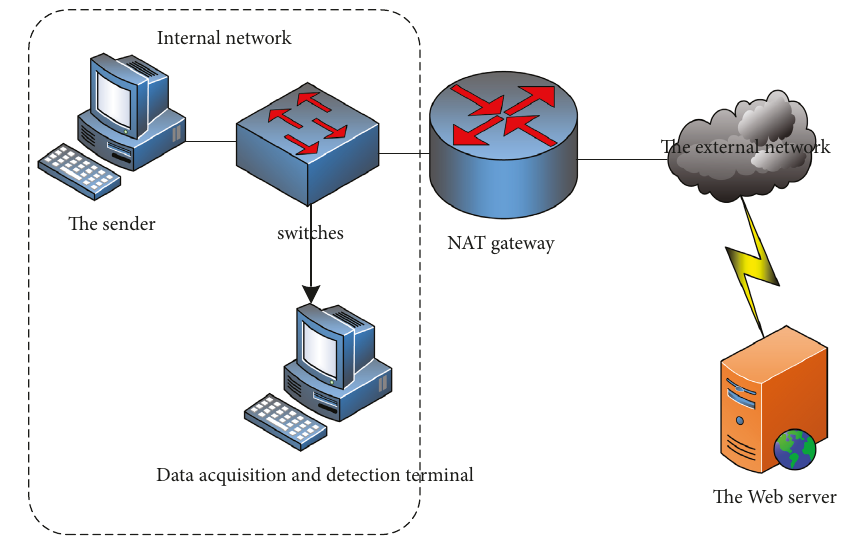
Figure 2: Network topology of the experimental